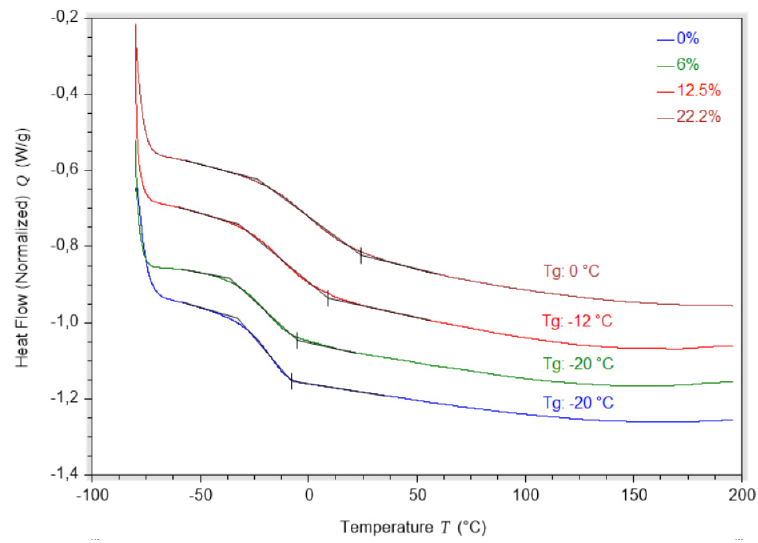
Figure 3. Influence of the KL MeOH content (expressed as weight%) on the T g.